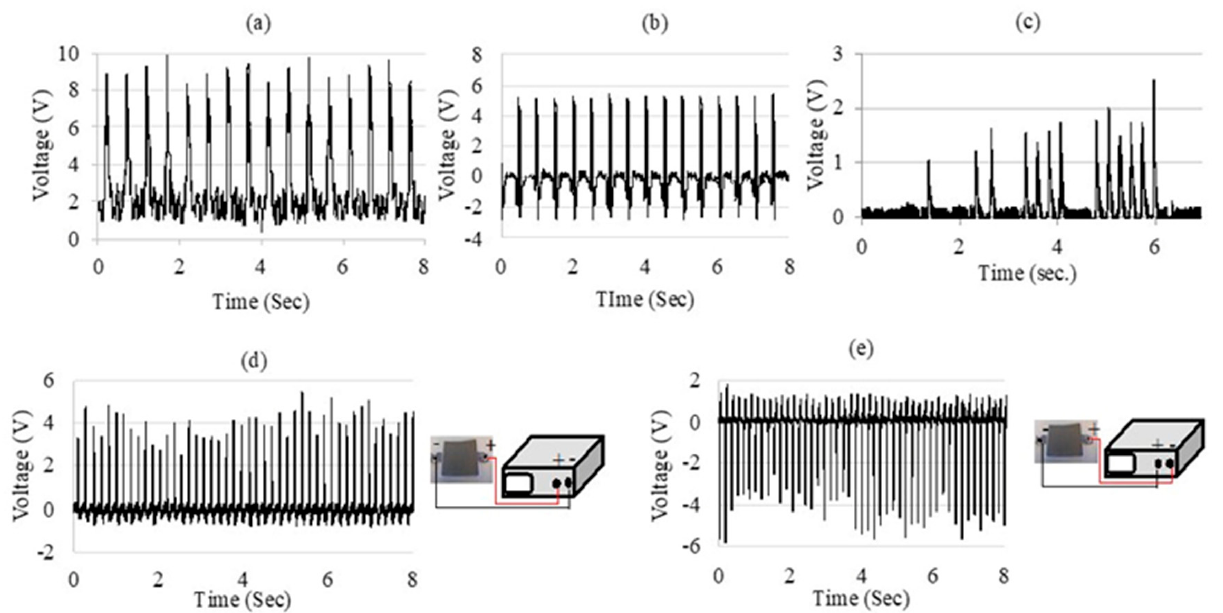
Figure 5. The voltage responses of the PSTS was recorded under different condition by measuring ( a ) with and ( b ) without the rectifier circuit while tapping with one’s finger; ( c ) the output voltage at different frequencies, 1–5 Hz; ( d ) with forward bias and ( e ) reversed bias.